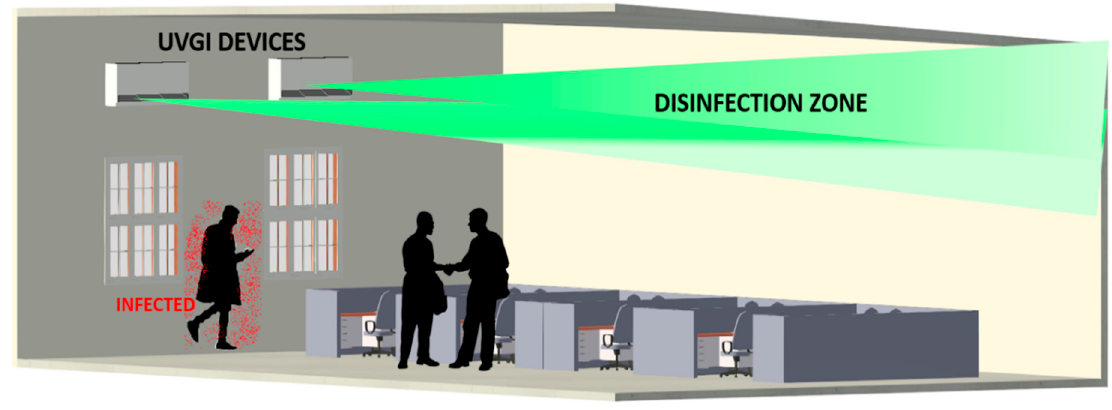
Figure 9. Potential application of ultraviolet germicidal irradiation (UVGI) technology .